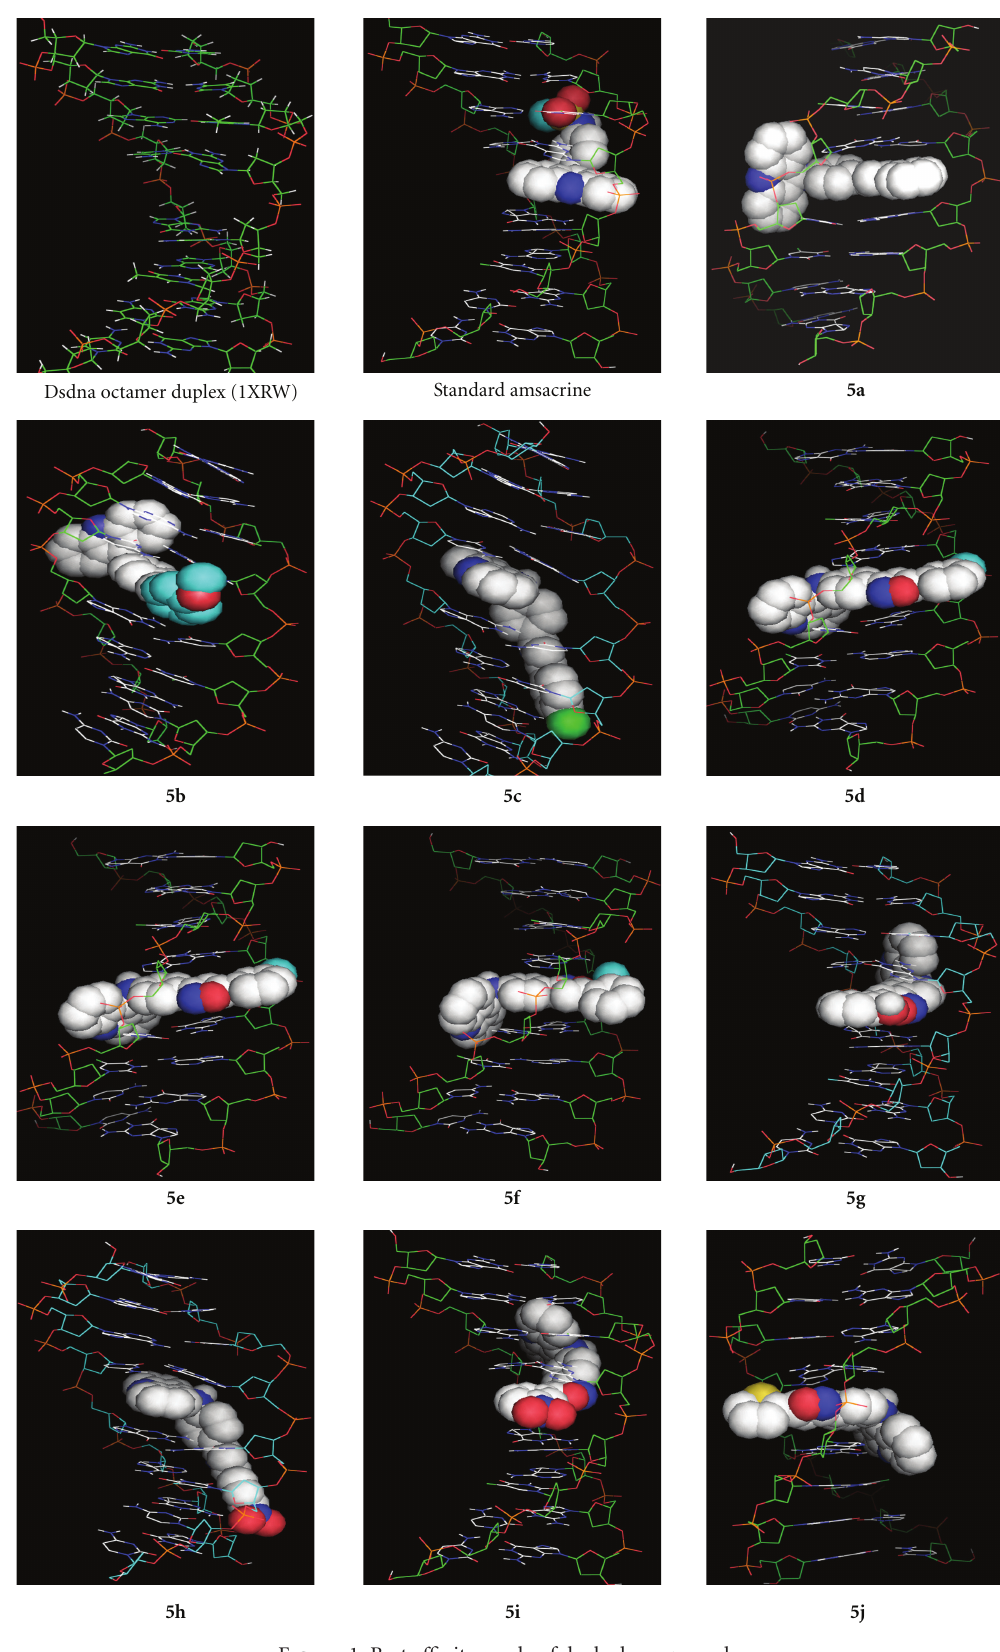
Figure 1: Best a ffi nity mode of docked